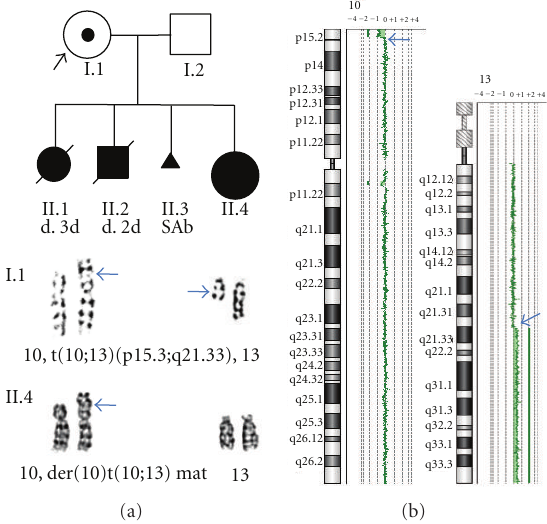
Figure 2: Cytogenomic results of the fetus. (a) Pedigree of the proband shows two neonatal deaths at 3 and 2 days (II . 1 and II . 2) and a spontaneous abortion (SAB, II . 3). Arrows point to the reciprocal translocation of t(10;13) in the proband (I . 1) and the derivative chromosome 10 in the fetus (II . 4). (b) aCGH chromosome views show the small 2.339 Mb distal 10p deletion and the large 46.344 Mb 13q duplication (arrows point to the